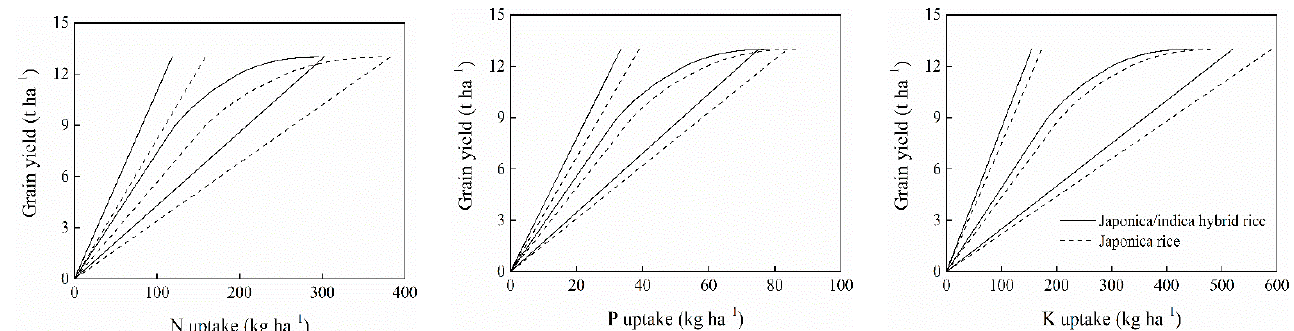
Figure 4. The nutrient requirements of japonica/indica hybrid rice and japonica rice in above-ground dry matter at a grain yield of 13 t ha − 1 , based on Set I.